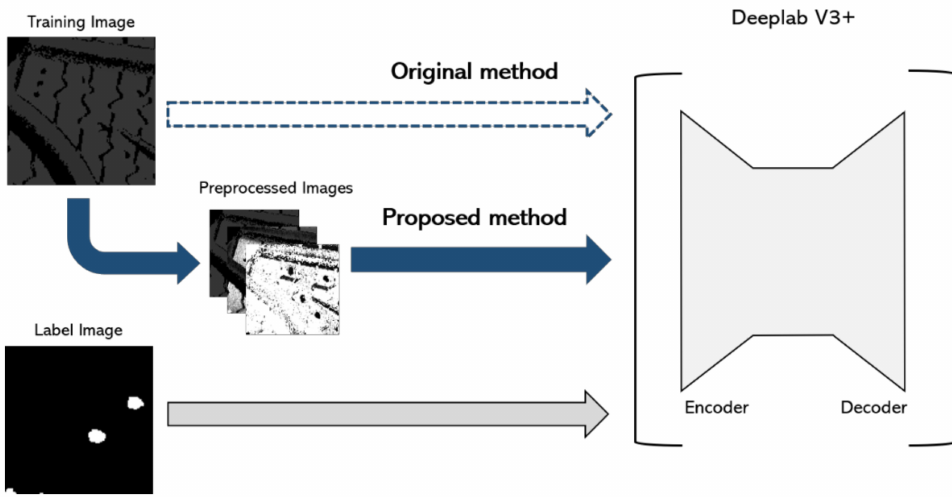
Figure 1. Comparison of the existing training method and the proposed